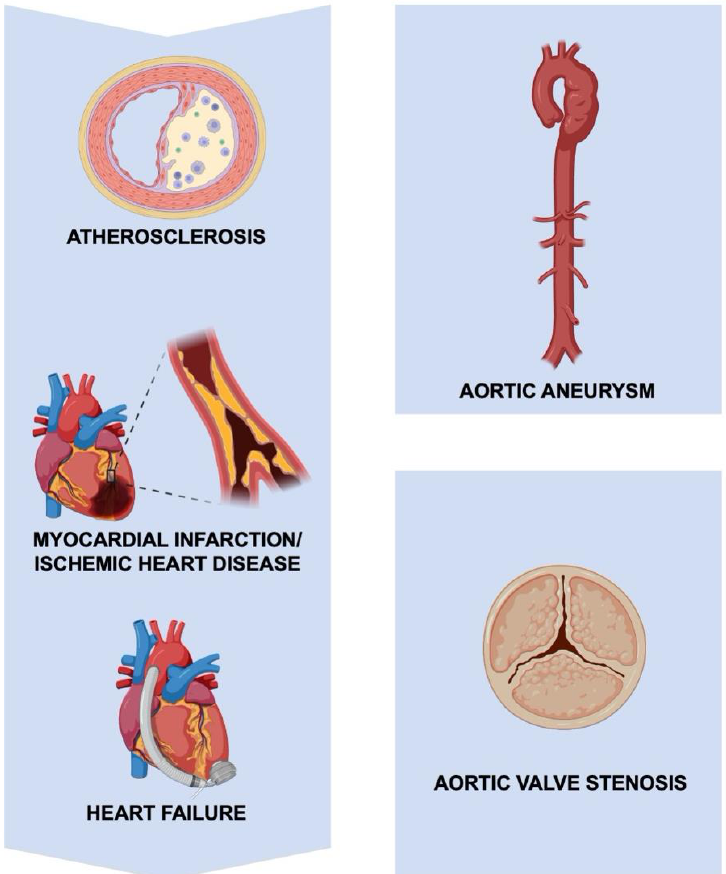
Figure 1. Cardiovascular diseases. Cardiovascular diseases, including the progression of atherosclerosis to ischemic heart disease and heart failure, aortopathy, and valvular pathology. EVs are nano-sized, membrane-bound vesicles released by nearly all cells. EVs are